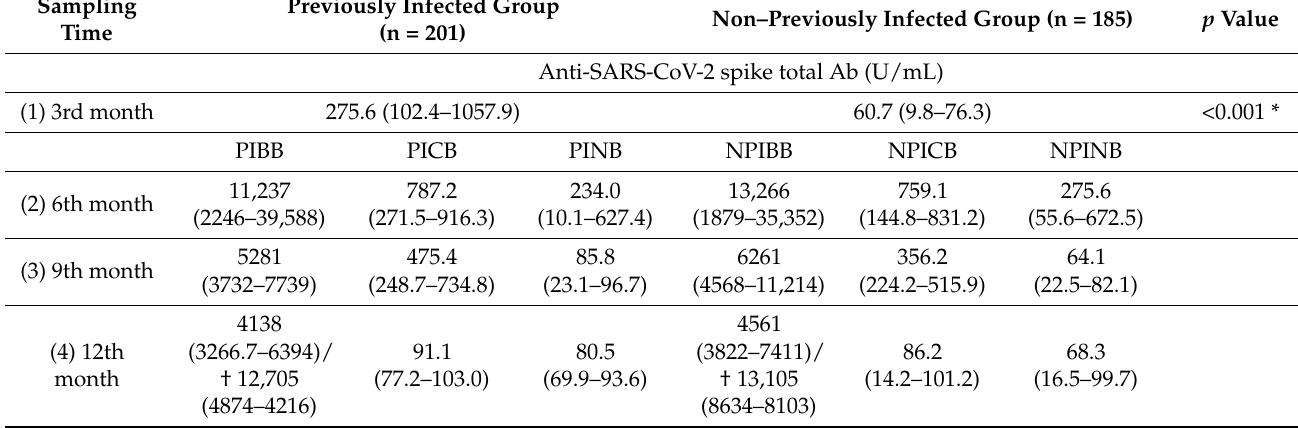
Table 2. Geometric means of anti-SARS-CoV-2 spike total Ab and neutralizing Ab titers of the study groups in four sampling periods for 12 months (PI = previously infected, NPI = non-previously infected, PIBB = previously infected BioNTech booster receiver, PICB = previously infected Coro- naVac booster receiver, PINB = previously infected non booster receiver, NPIBB = non-previously infected BioNTech booster receiver, NPICB = non-previously infected CoronaVac booster receiver, NPINB = non-previously infected non booster receiver groups, n = number of the participants, and 95% CI = 95% confidence interval of